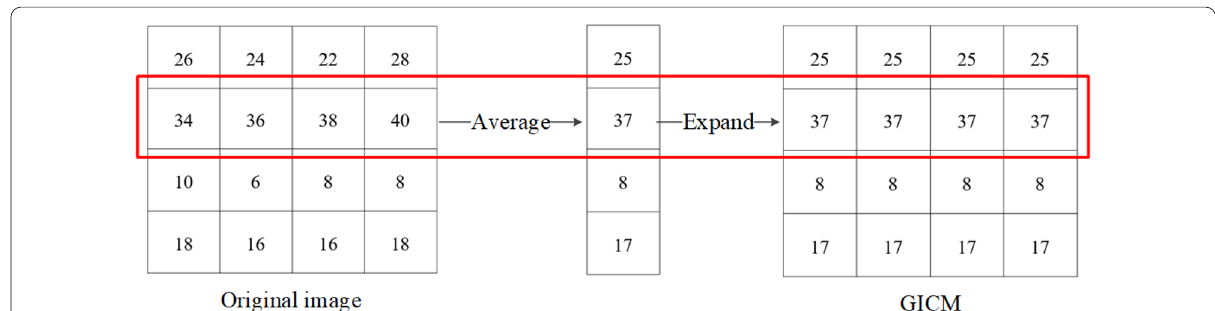
Fig. 3 Generation method of